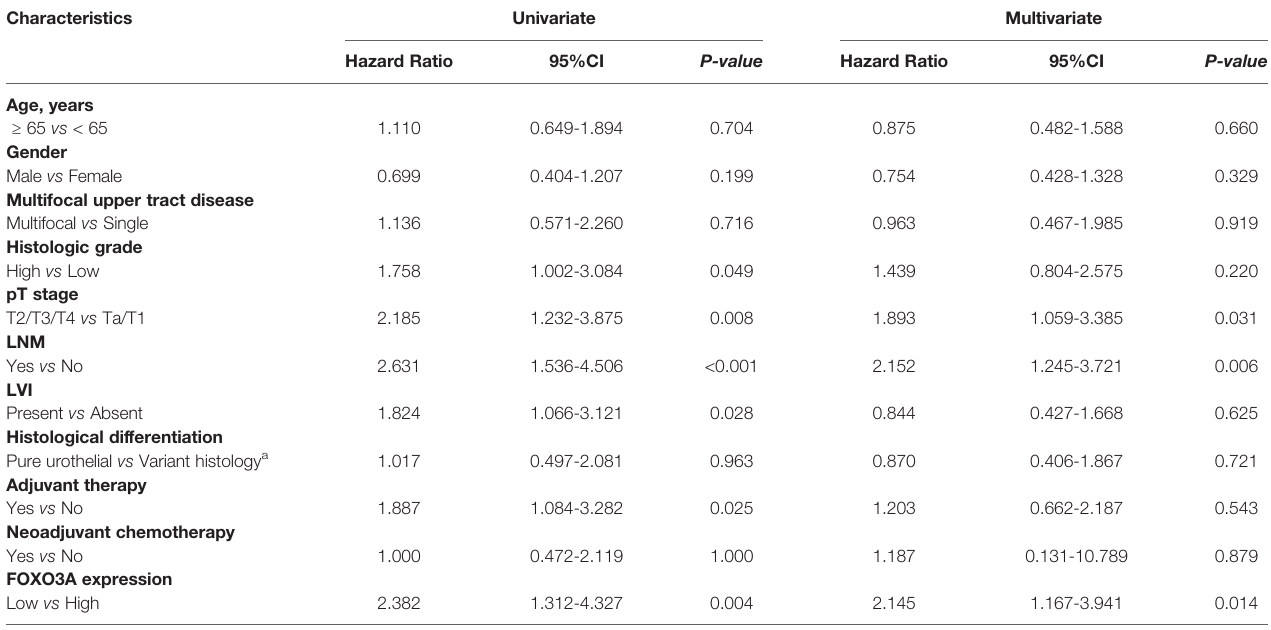
FOXO3A protein expression were ultimately determined to be predictors of the OS ( P = 0.031, P = 0.006, P = 0.014) and RFS ( P = 0.022, P = 0.004, P = 0.010) of UTUC patients in the multivariate analyses ( Tables 2 , 3 ).